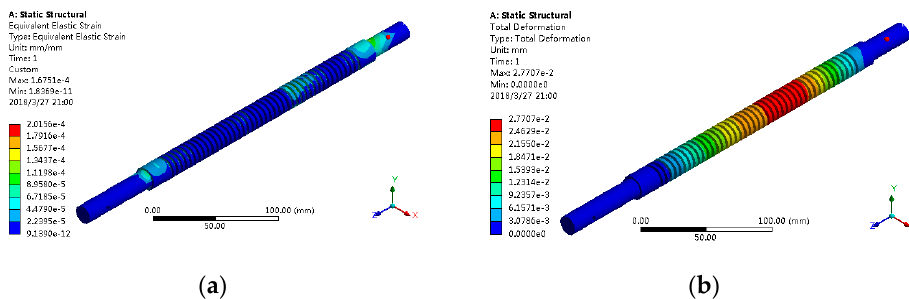
and ( b ) total deformation.